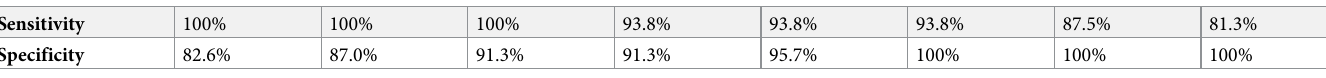
Table 3. Coordinates of anti-SSA/TRIM29 combination